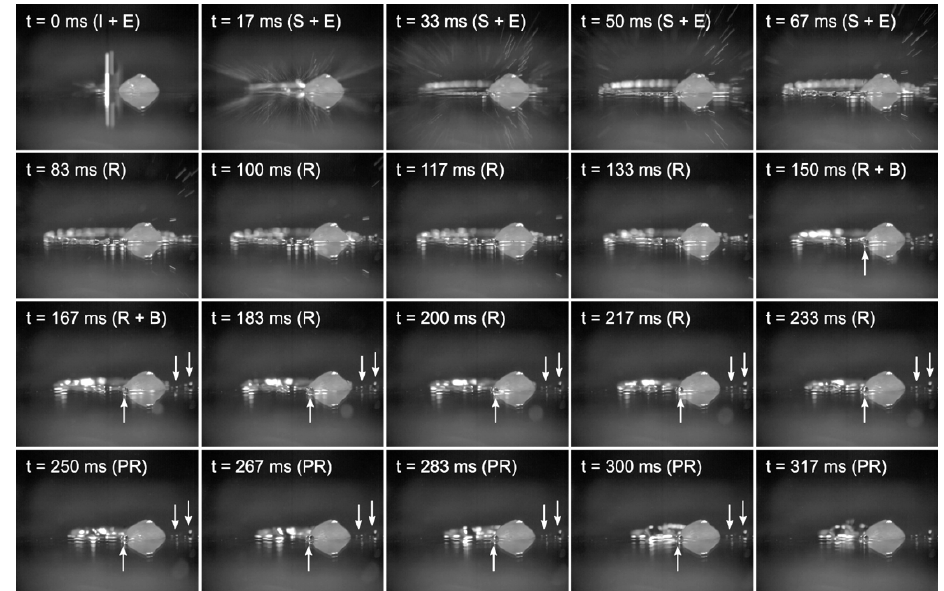
Figure 4. Frames from the high-speed camera configuration of a supercooled water drop impact on an ice particle when both the drop and ice particle are at − 5 ◦ C. The impact phase (I), spreading phase (S), secondary drop formation/ejection during the spreading phase (E), retraction phase (R), secondary drop formation due to the receding break-up (B) and partial rebound (PR) of the water drop are indicated in the frames. Arrows indicate secondary drop formation during the retraction phase of the supercooled water drop.